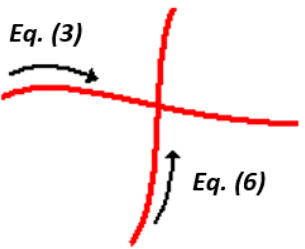
Figure 4. Mathematical model of the two light projections.